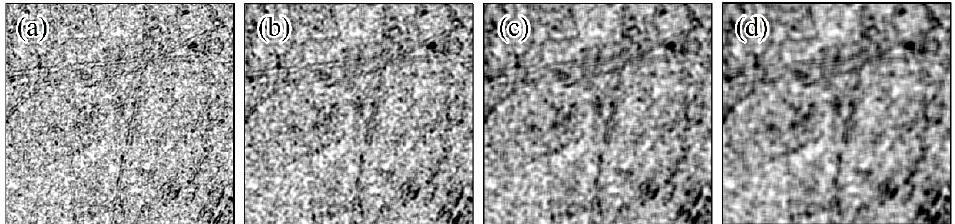
Figure A2. Comparison of texture feature (homogeneity) extraction effects with different window sizes: ( a ) window size of 3 × 3; ( b ) window size of 5 × 5; ( c ) window size of 7 × 7; ( d ) window size of 9 × 9.